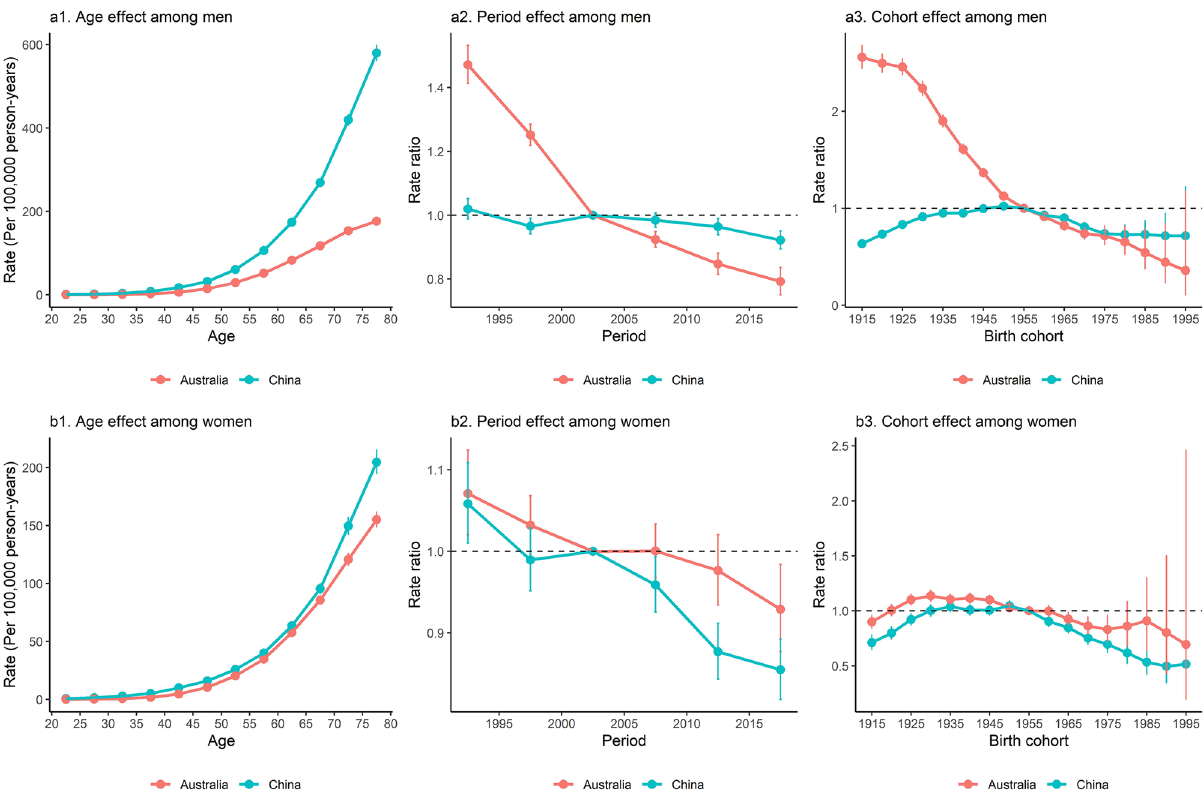
Figure 5. Parameter estimates of age, period, and cohort effects on lung cancer mortality in China and Australia, 1990 to 2019. ( a1,b1 ) show the longitudinal age curves of lung cancer mortality (per 100,000 person- years) and the 95% CIs among men and women in the two countries, respectively, representing the expected age-specific rates in reference cohort adjusted for period effect. ( a2,b2 ) show the rate ratios of lung cancer mortality in different periods (period effects) relative to the reference period (2000–2004) adjusted for age and cohort effect, and the 95% CIs among men and women in the two countries, respectively. ( a3,b3 ) show the rate ratios of lung cancer mortality in different cohorts (cohort effects) relative to the reference cohort (1953–1957) adjusted for age and period effect, and the 95% CI among men and women in the two countries,